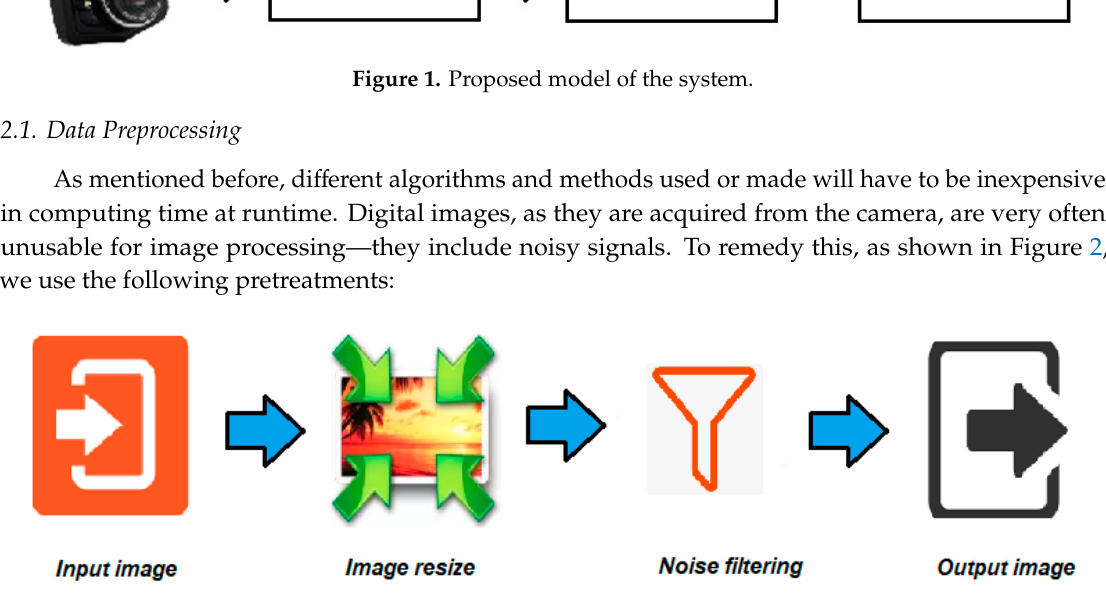
Figure 2. Data preprocessing steps.